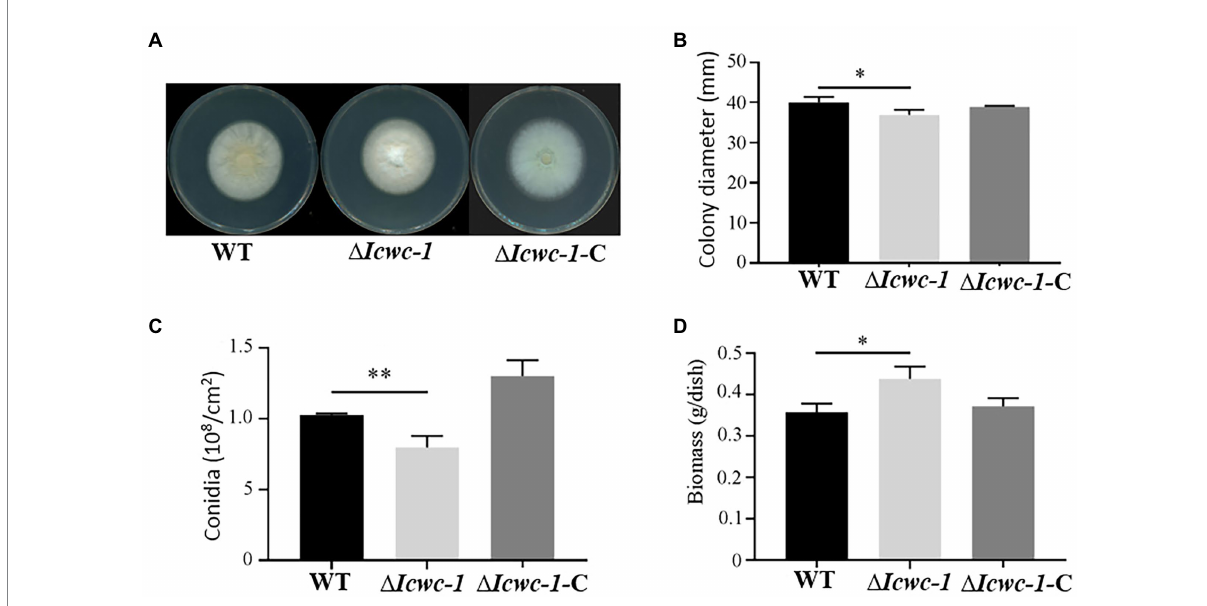
FIGURE 3 Effect of Icwc-1 gene on growth characters in I. cicadae. (A) Colony characters of different strains (wild-type, ∆ Icwc-1 and ∆ Icwc-1 -C) of I. cicadae were photographed and recorded after 10 days of alternating light and dark culture on PDA medium; (B) 5 μ l of the spore suspension is inoculated on PDA medium, cultured under white light conditions for 10 days, and the colony diameter was recorded; (C) The strains were cultured on a PDA plate for 10 days at 25 ° C, spores were washed with water, diluted to a certain concentration and counted under a microscope; (D) Effects of Icwc-1 gene deletion on mycelial biomass of I. cicadae. The symbol “ * ” indicates a significant difference ( p < 0.05) compared with wild-type strain. The symbol ‘ ** ’ indicates significant difference ( p < 0.01) compared with wild-type